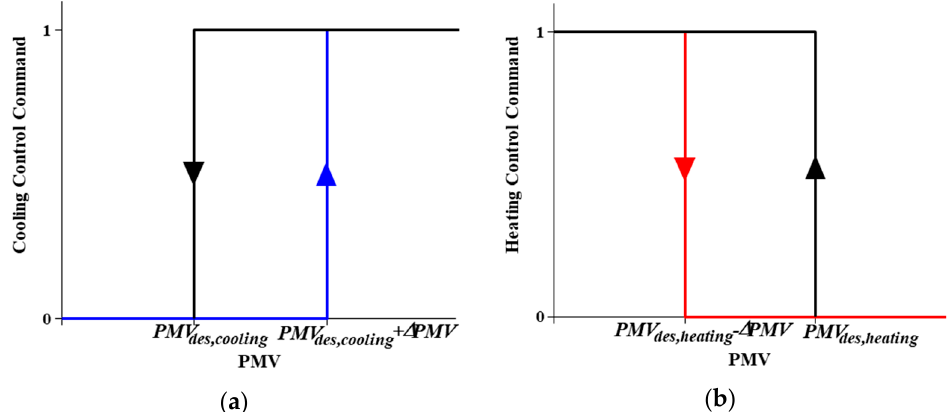
Figure 3. Control command of the HVAC system based on acceptable PMV range: ( a ) cooling process and ( b ) heating process.